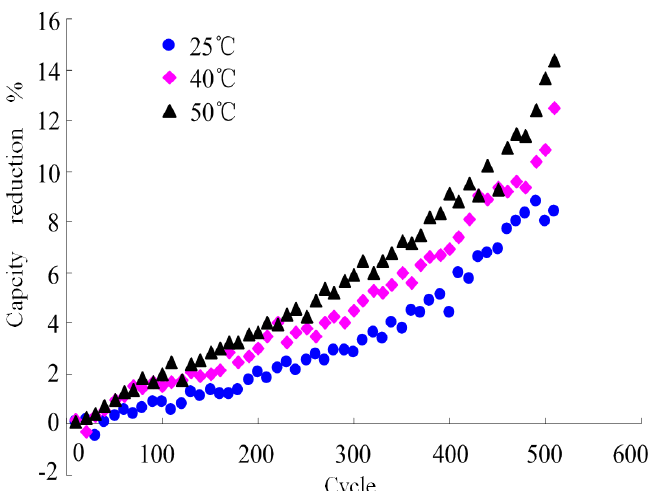
Figure 2. Capacity percent reductions.